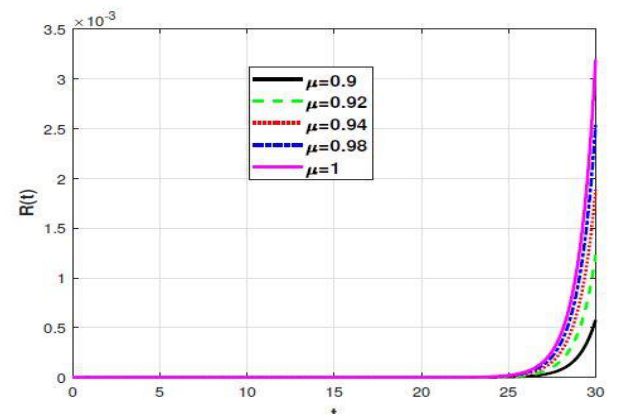
Fig. 5. Numerical experiments of ailing symptomatic infected class for various value of fractional order 𝛍 .